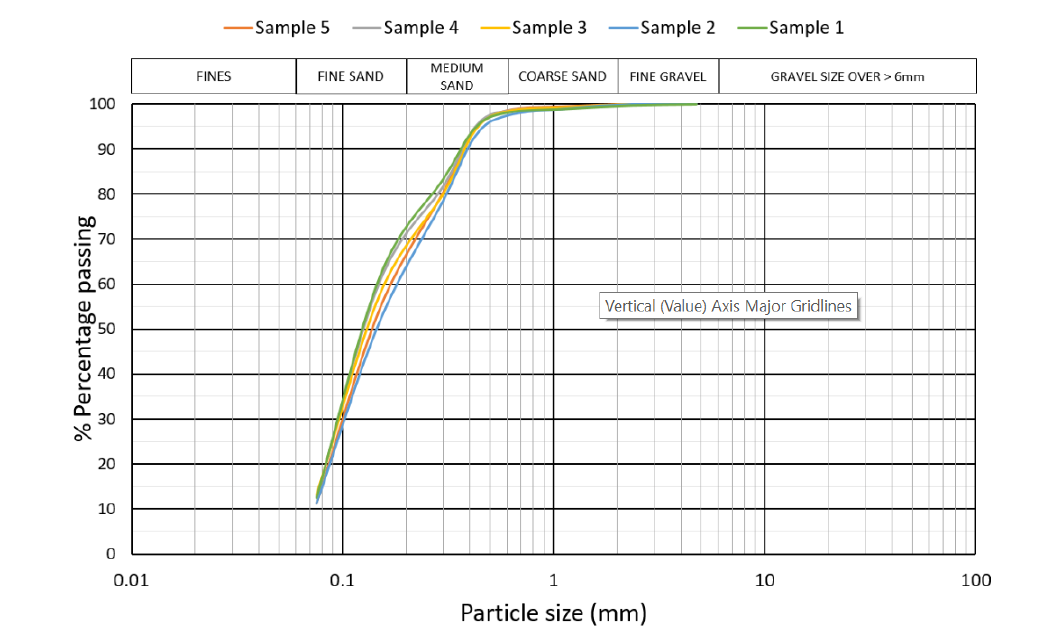
Figure 2. Typical soil grading curves for a greyhound racing